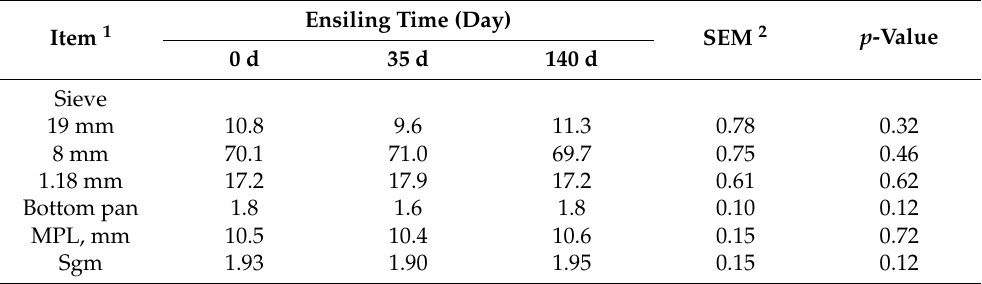
Table 3. Effect of ensiling time on particle size distribution and mean particle length in whole-plant corn silage harvested with a pull-type forage